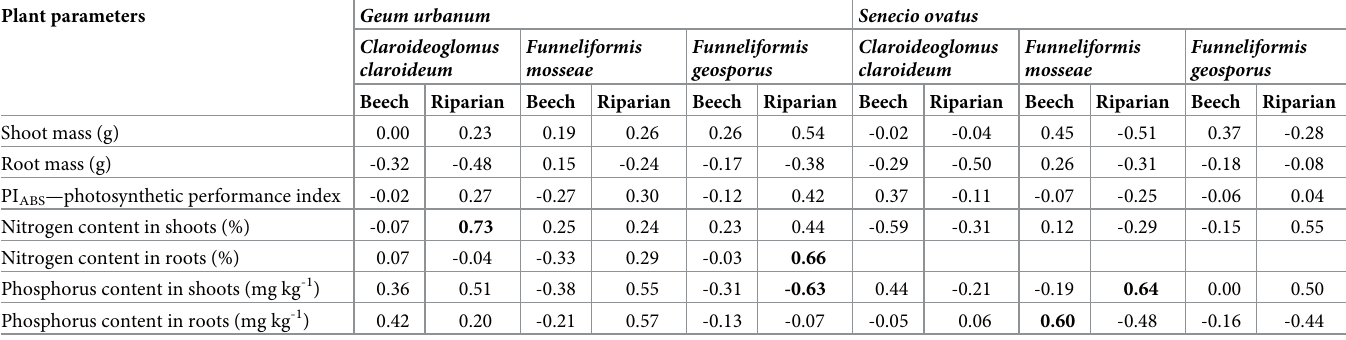
Table 3. Pearson’s correlation coefficients between relative mycorrhizal root length and mass of shoots and roots, photosynthetic performance index, and contents of phosphorus and nitrogen in Geum urbanum and Senecio ovatus for particular arbuscular mycorrhizal fungi species treatments and soil